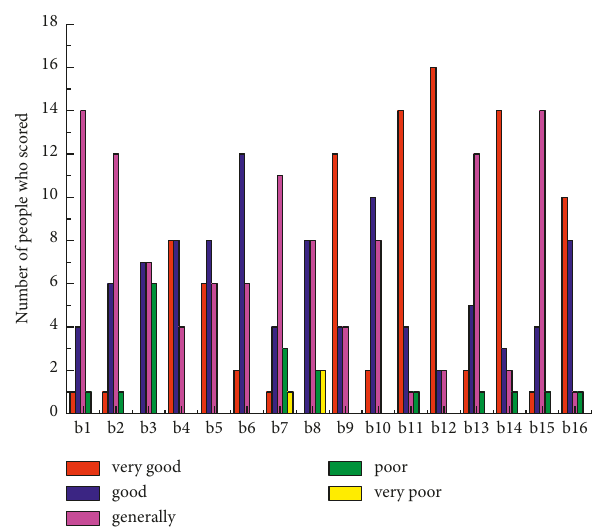
Figure 7: The expert scoring results of the indicator data.